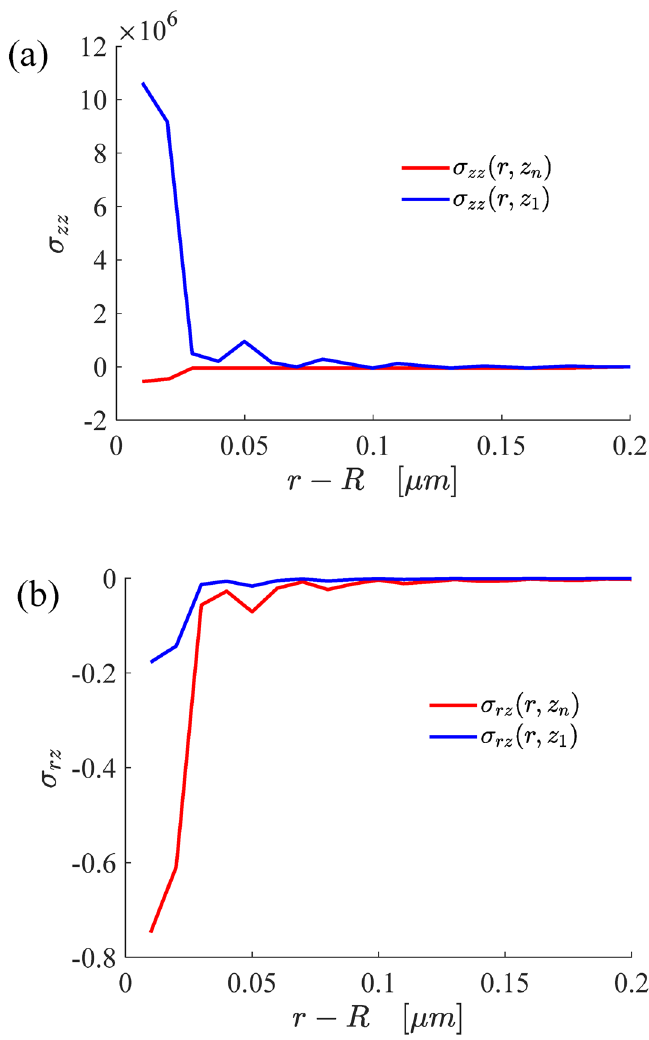
Figure 7. The variations of the normal stress ( a ) and radial shear stress ( b ) on the surface and